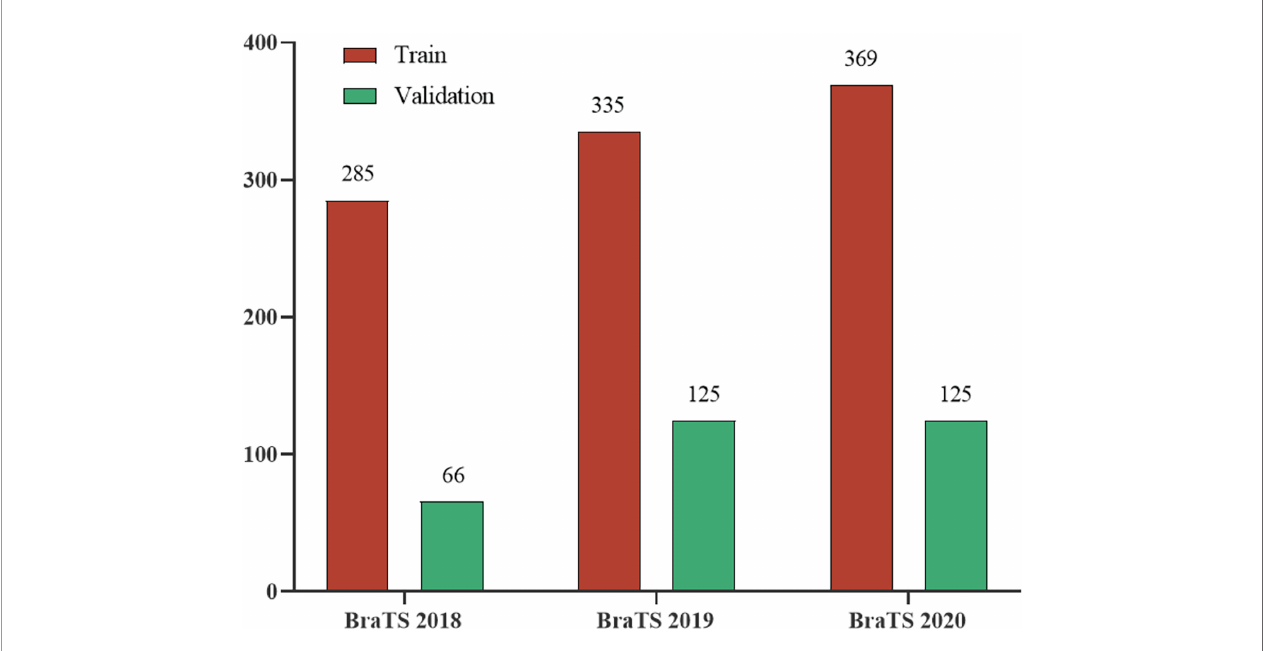
FIGURE 4 | The division of the three datasets in the BraTS